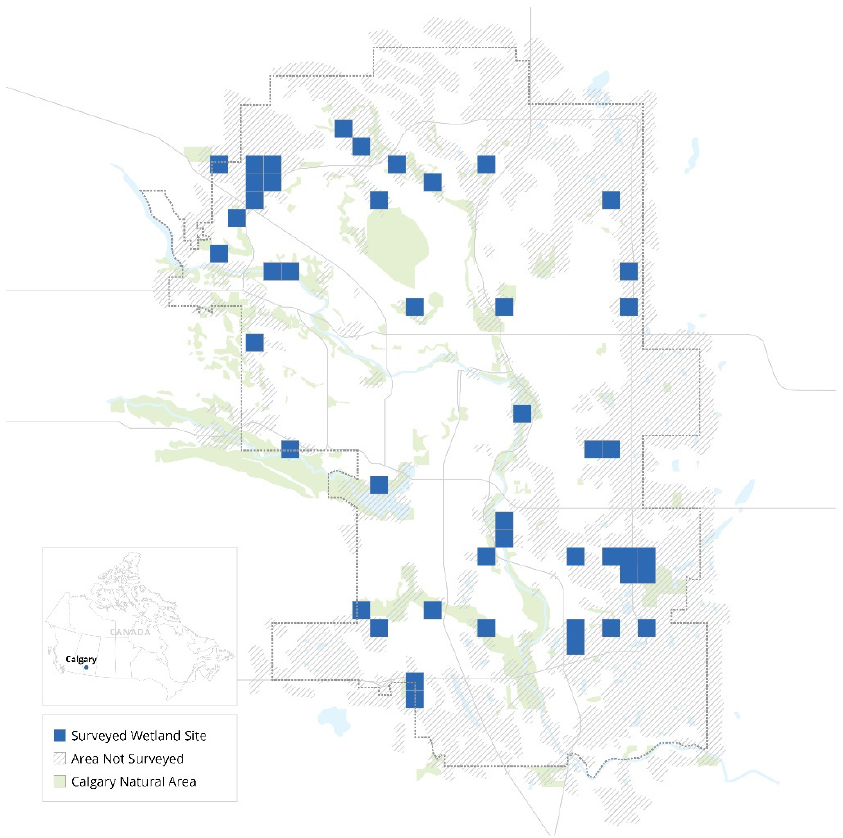
Figure 1. Map depicting wetland areas surveyed by citizens in Calgary, AB, Canada. More than one wetland site can occur in a blue square.